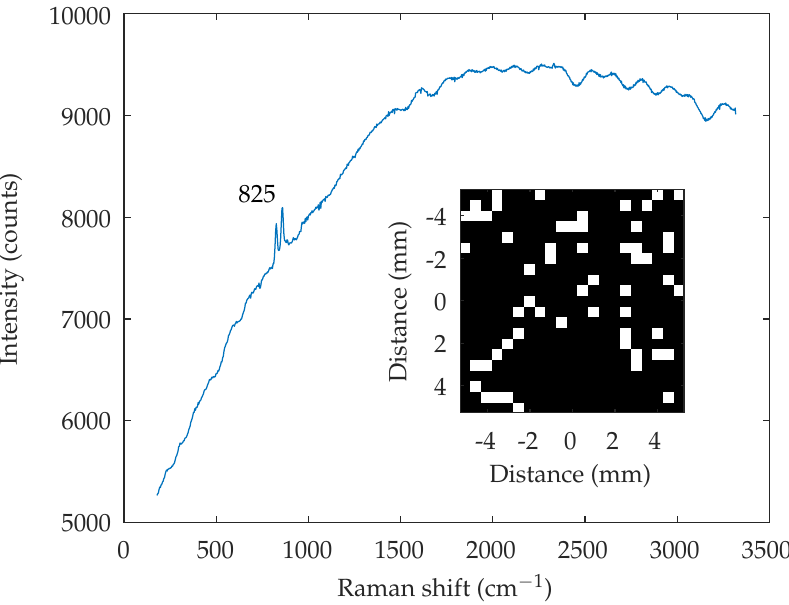
Figure 7. Average Raman spectrum from the nickel ore. The inset shows the map of forsterite (band at 825 cm − 1 ) for which the signal-to-background ratio was larger than 3. The white dots are locations where the Raman band of forsterite was